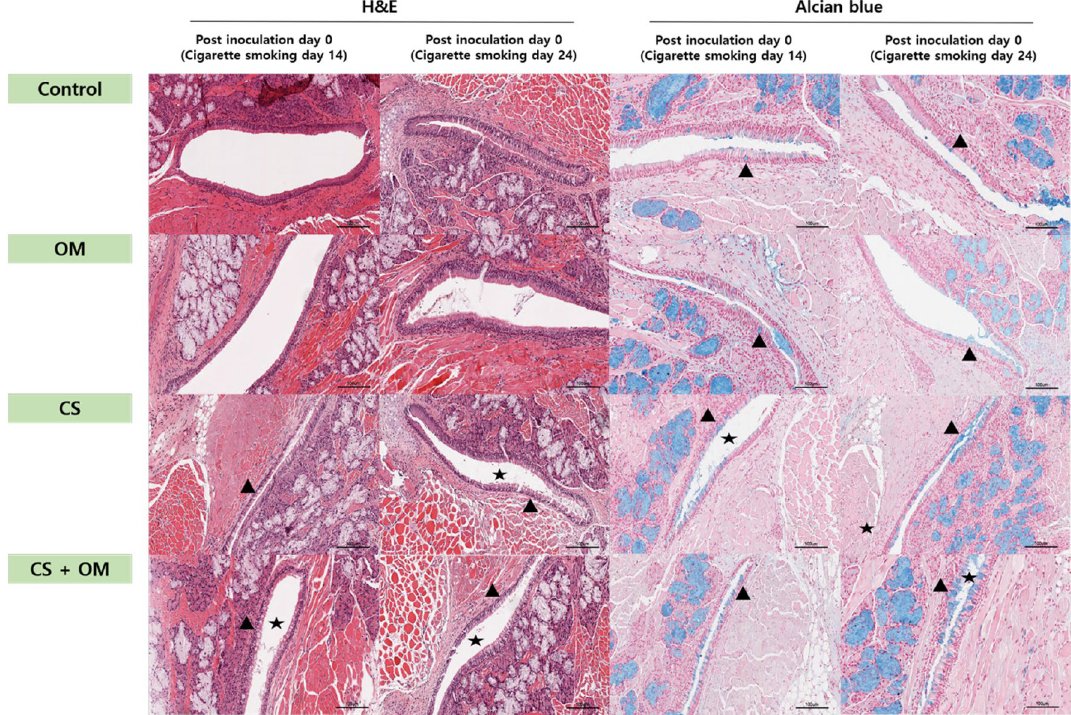
Figure 5. Light microscopic findings of the Eustachian tube at various time points. Left panels show sections stained using hematoxylin and eosin (×200 magnification); the right panels show sections stained using alcian blue (×200 magnification). The control and otitis media (OM) groups are not exposed to cigarette smoke (CS). At day 0 of inoculation, the CS and CS + OM groups have already been exposed to CS for 2 weeks. The loss of cilia (asterisk) and the number of goblet cells (arrowheads) are greater in the CS and CS + OM groups than in the control and OM